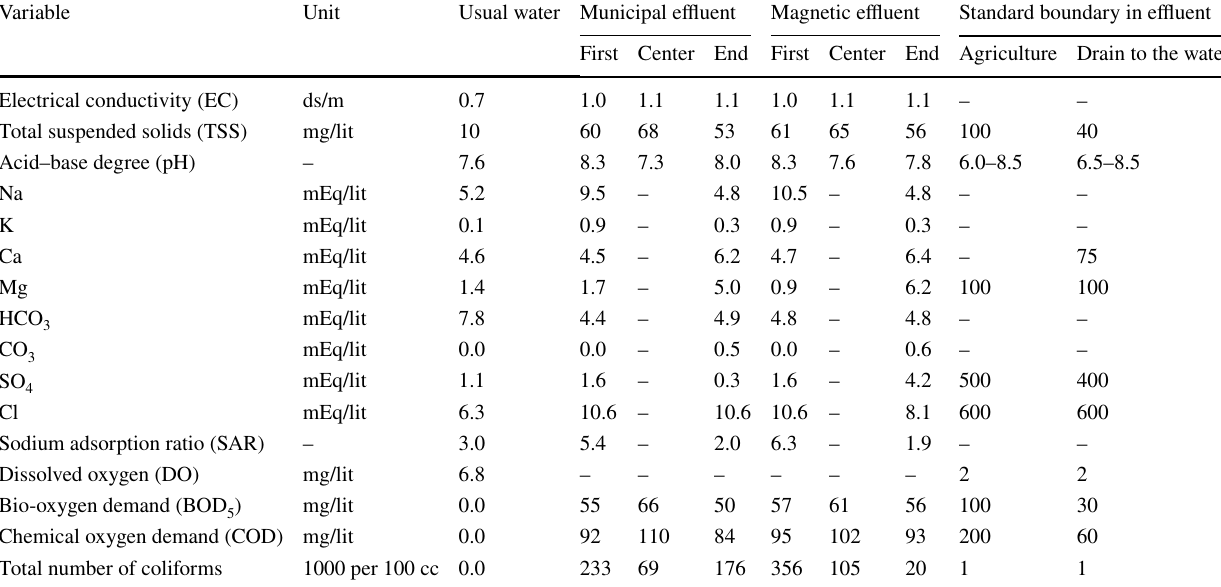
Table 2 Some chemical, physical and biological variables of water, effluent and magnetic effluent Variable